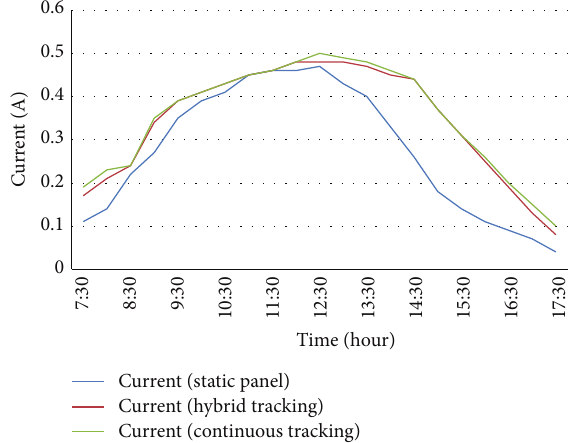
Figure 13: Comparison curve: comparison of current versus time curve for the static panel, hybrid tracking system, and continuous tracking